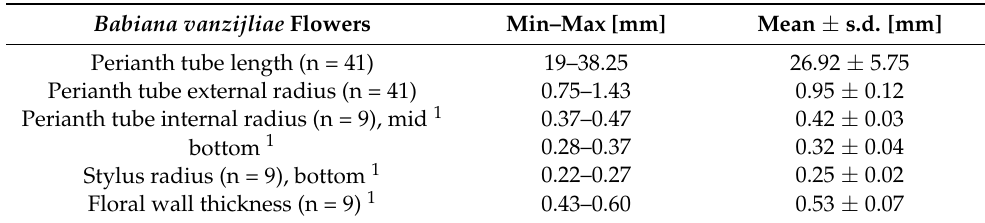
Table 2. Perianth tube length and diameter of Babiana vanzijliae (Iridaceae) at the study site (Northern